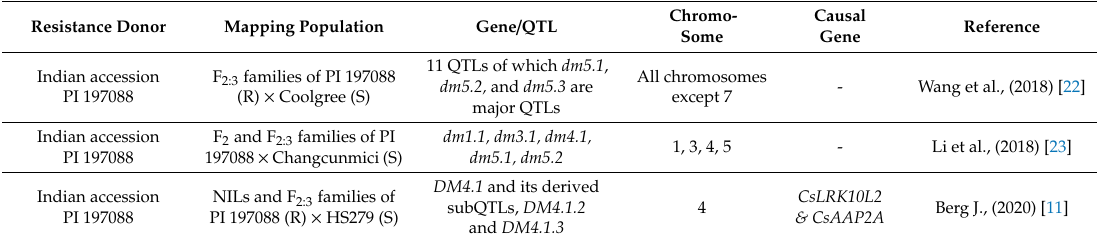
Figure 2. Box plots depicting the phenotypic distribution of disease index (DI) of downy mildew (DM) resistance in four experiments and among different ecotypes. ( a ) Phenotypic distribution in four experiments; ( b ) DI distribution in four ecotypes.